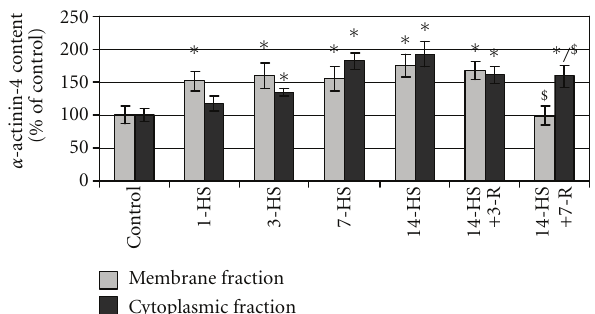
Figure 5: Alpha-actinin-4 content in the rat’s left ventricular myocytes under gravitational unloading and subsequent reloading; n = 7 samples for each group; ∗ P < 0 . 05 as compared to the group “Control”, $ P < 0 . 05 as compared to the group